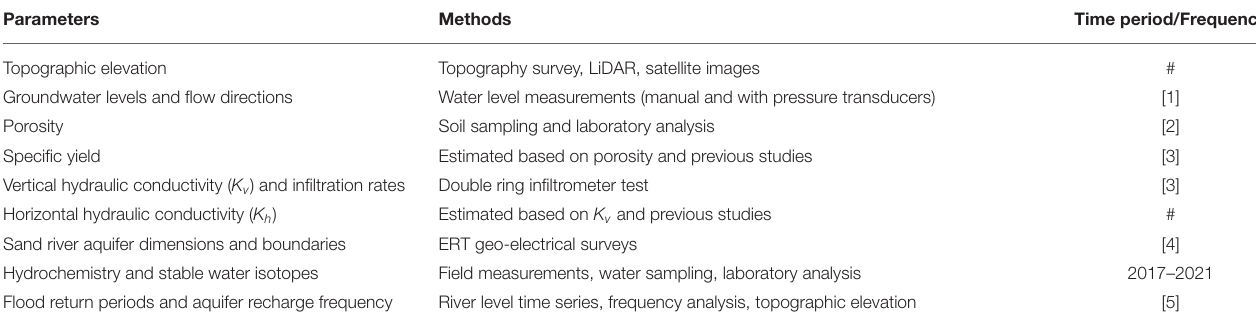
TABLE 1 | Employed methods for estimation of sand river parameters, hydrochemistry and recharge rates, and